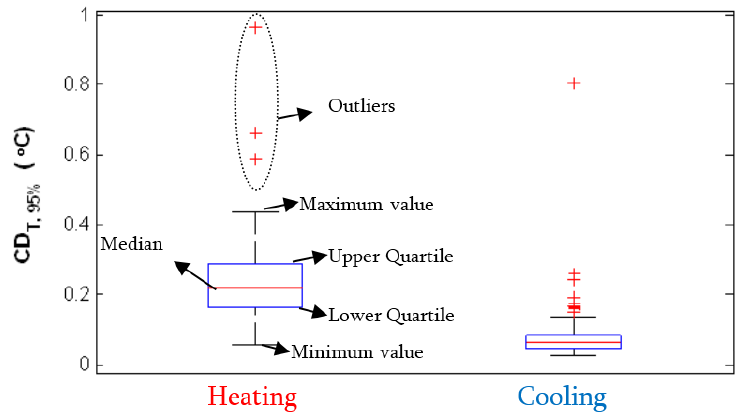
Figure 14. Comparison of heating and cooling TR repeats (95% confidence deviation of temperature uncertainty). Fibers 2016 , 4 , 29